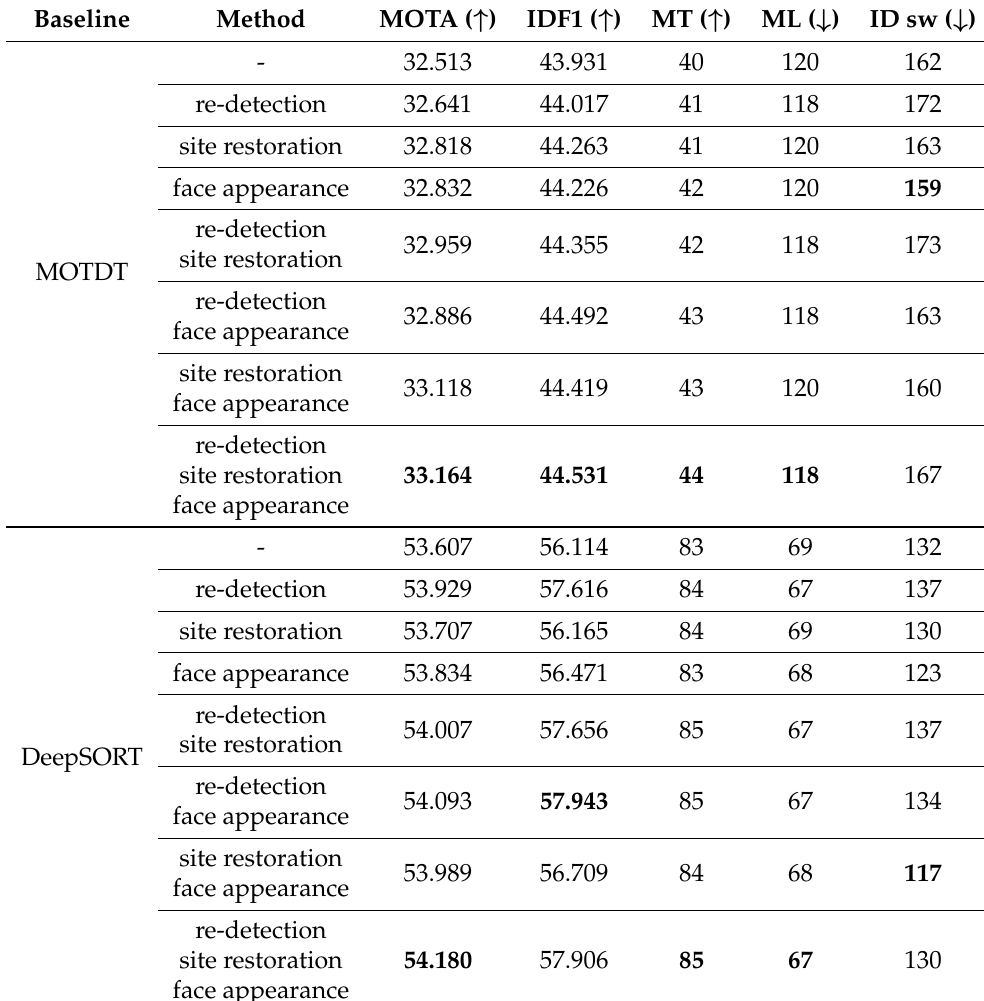
Table 2. Experimental results of ablation studies based on the baseline trackers, MOTDT and DeepSORT. Highlighting represents the best